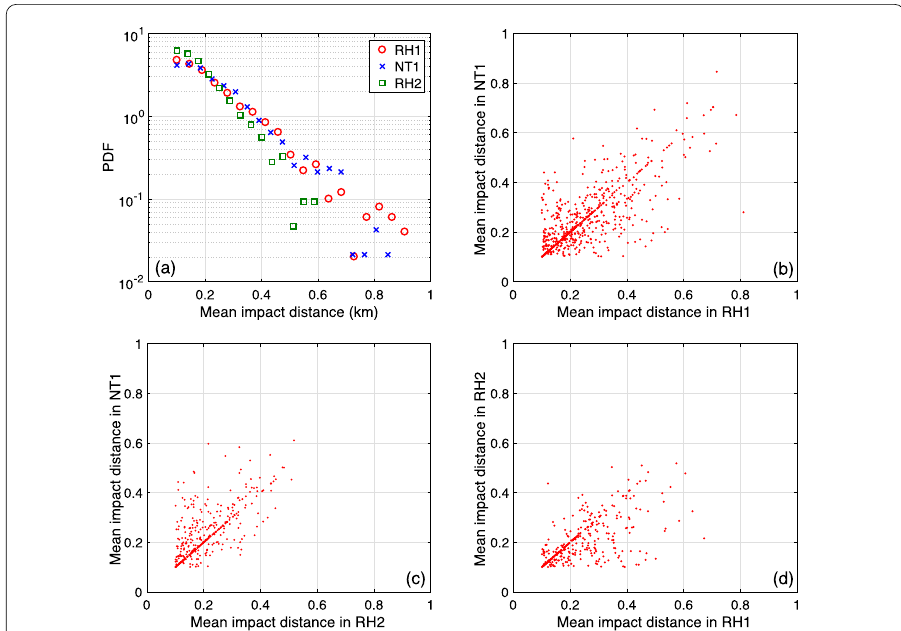
Figure 9 Statistics of the mean impact distance of nodes. ( a ) PDF of mean impact distance at RH1 (red circles), NT1 (blue crosses), and RH2 (green squares). ( b ) Mean impact distance (in km) during NT1 VS during RH1. ( c ) Mean impact distance during NT1 VS during RH2. ( d ) Mean impact distance during RH2 VS during RH1. The data is during 26–30 Oct. 2015, N = 4530, L = 900, and τ max = 150. Pearson’s correlation: ( b ) 0.7463, ( c ) 0.6926, ( d ) 0.6402